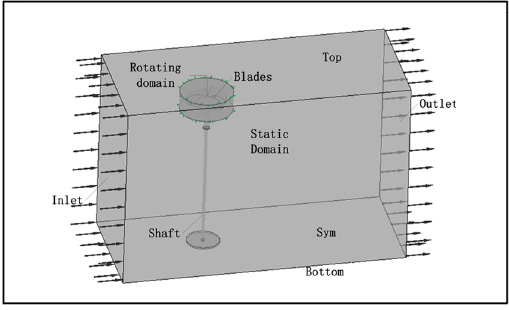
Figure 3. Fluid domain boundary setting.